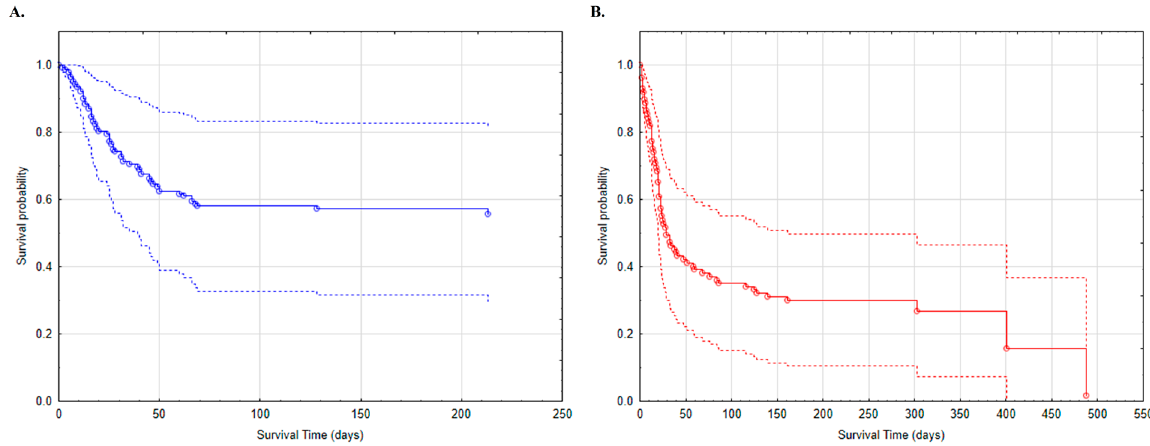
Figure 3. Survival analysis of patients with COVID-19 and wheezes/rhonchi on admission to the hospital: ( A ) patients without cancer (blue); ( B ) patients with cancer (red).